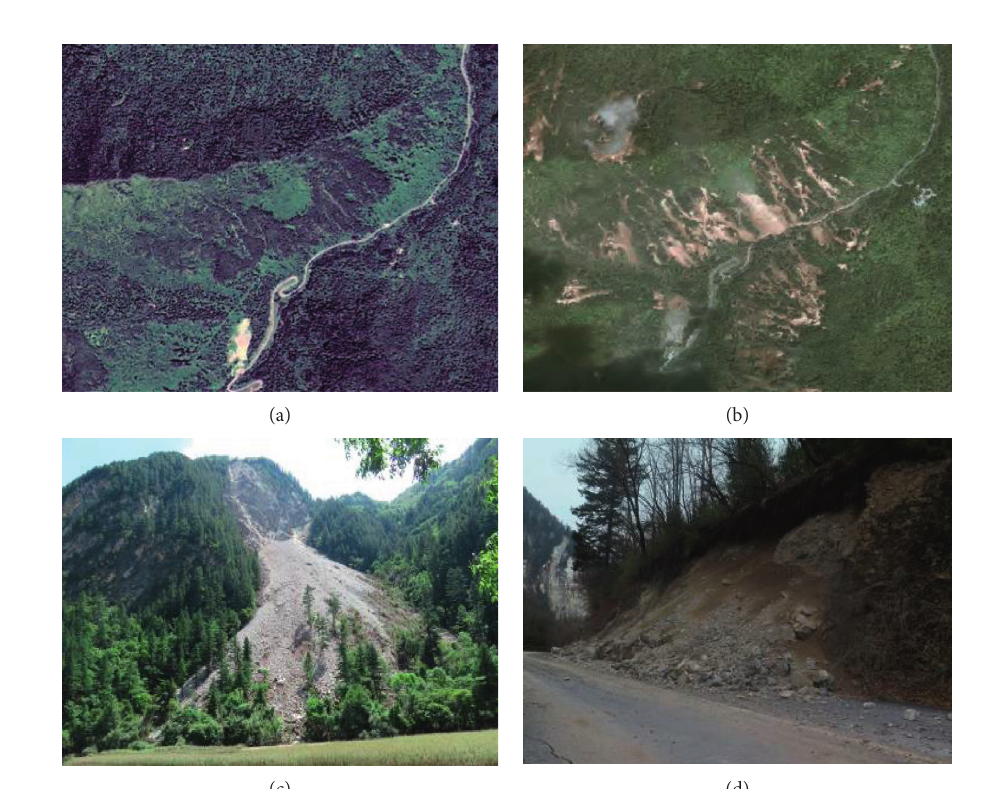
Figure 1: The location of the study area.